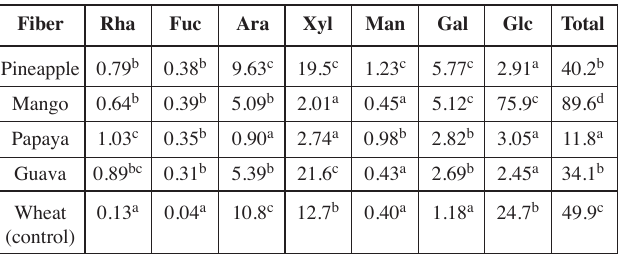
Tab. 2: Sum of the neutral sugars composition of fibers (g/100 g).